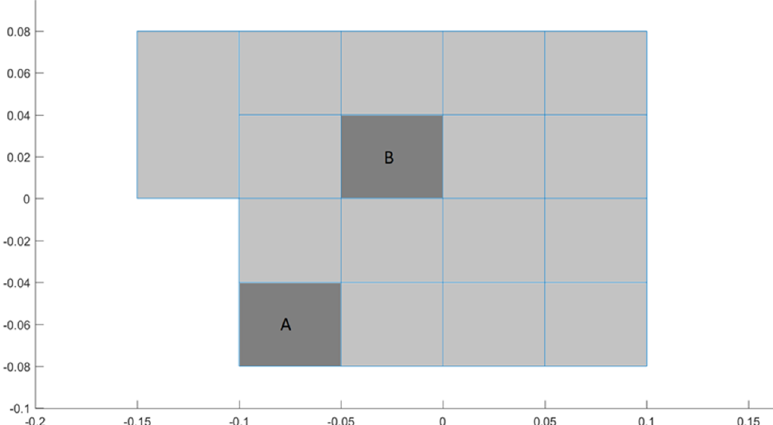
Figure 7. Two subarea blocks A and B are randomly selected to observe the simulation results. The cell demonstrated in 2D here is the same one as in Figure 1. The grids partitioned the cell into 16 subareas. The scales are to show the dimensions of the cell (Unit: